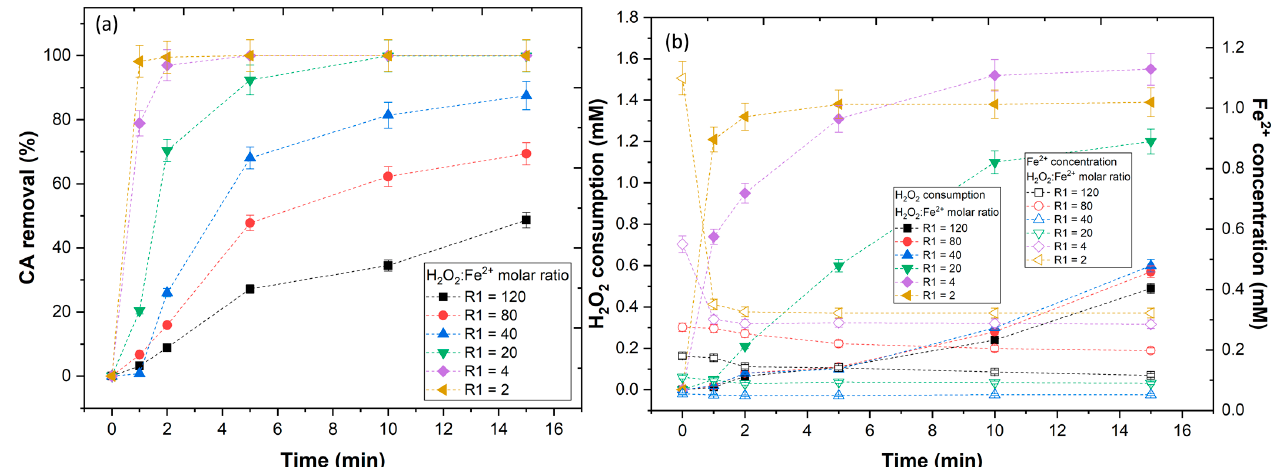
Figure 6. Assessment of the H 2 O 2 :Fe 2+ molar ratio in ( a ) CA degradation and ( b ) H 2 O 2 consumption and Fe 2+ concentration. Operational conditions: [CA] = 5.5 × 10 − 4 mol L − 1 , [H 2 O 2 ] = 22 × 10 − 4 mol L − 1 , pH = 3.0, agitation 150 rpm, temperature = 298 K, radiation UV-A, I UV = 32.7 W m − 2 , t = 15 min.